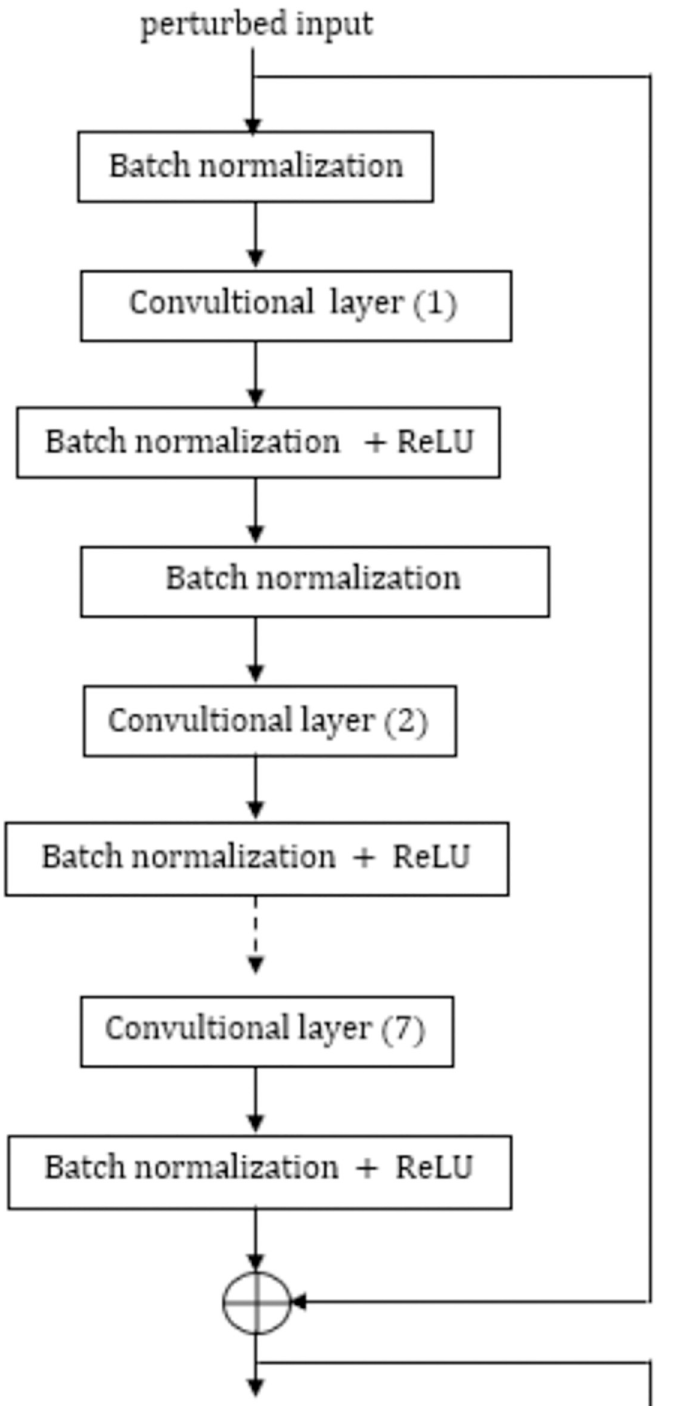
Fig 3. Single residual block in ShapAAL